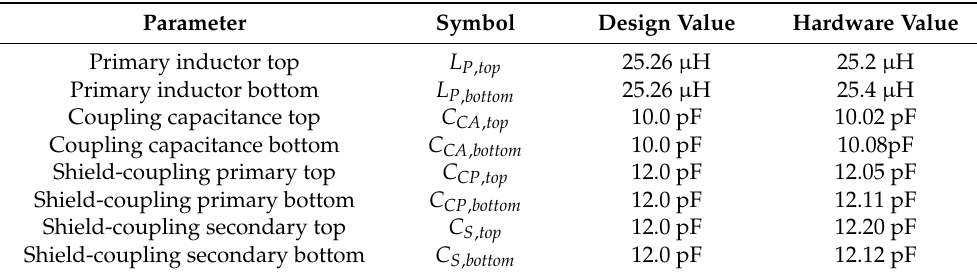
Table 3. Parameters of S-CPT based on the design and measurement